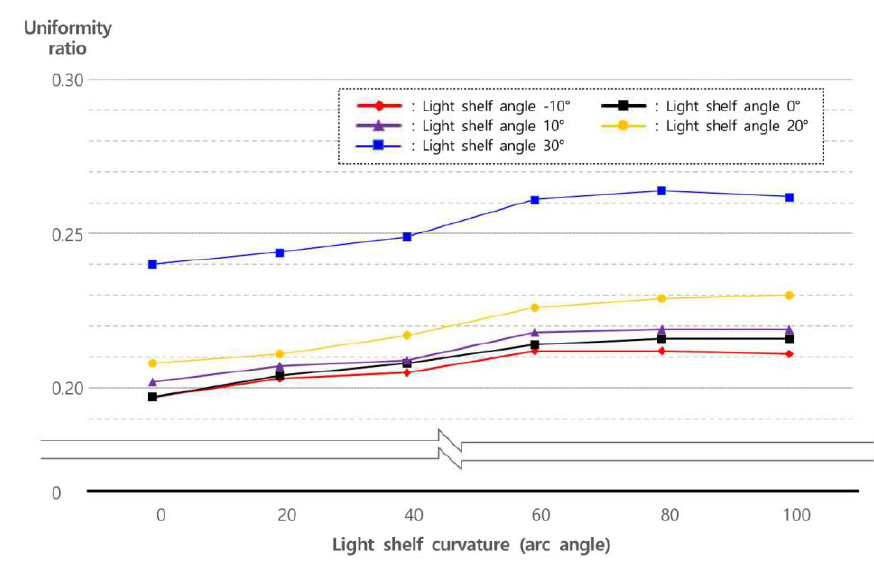
Figure 14. Uniformity ratio versus light shelf angle and arc angle during summer (external illuminance: 80,000 lx).